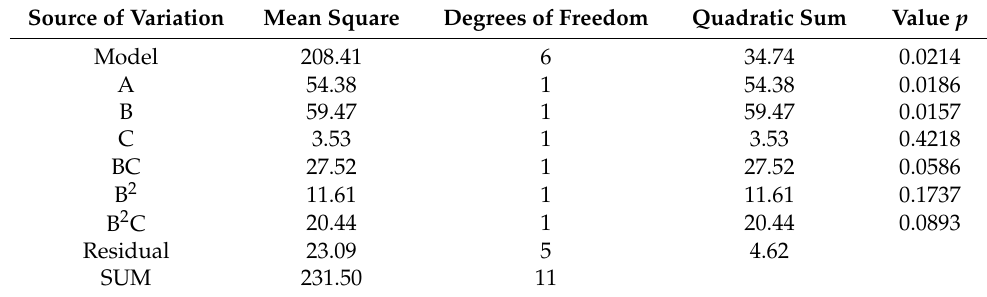
Table 8. Variance of 28-day curing cementitious material compressive strength model.